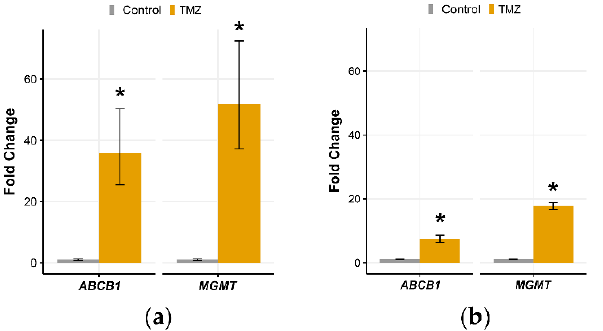
Figure 5. Increased expression of resistance-related genes after TMZ treatments in 2D and 3D long- term cell cultures. Quantitative real-time PCR analyses of ABCB1 and MGMT gene in long-term ( a ) 3D and ( b ) 2D U87 cell culture assessed after TMZ treatments and a recovery period. The mRNA from U87 cells was collected at the final time point (day 28). The expression of target genes was normalized to the ACTB gene as internal control and is presented as a relative value compared to the correspond- ing untreated control. Each sample was tested in triplicate. All results represent mean values ± SD ( n ≥ 3). * indicates p < 0.05 statistical difference compared to the corresponding control cells